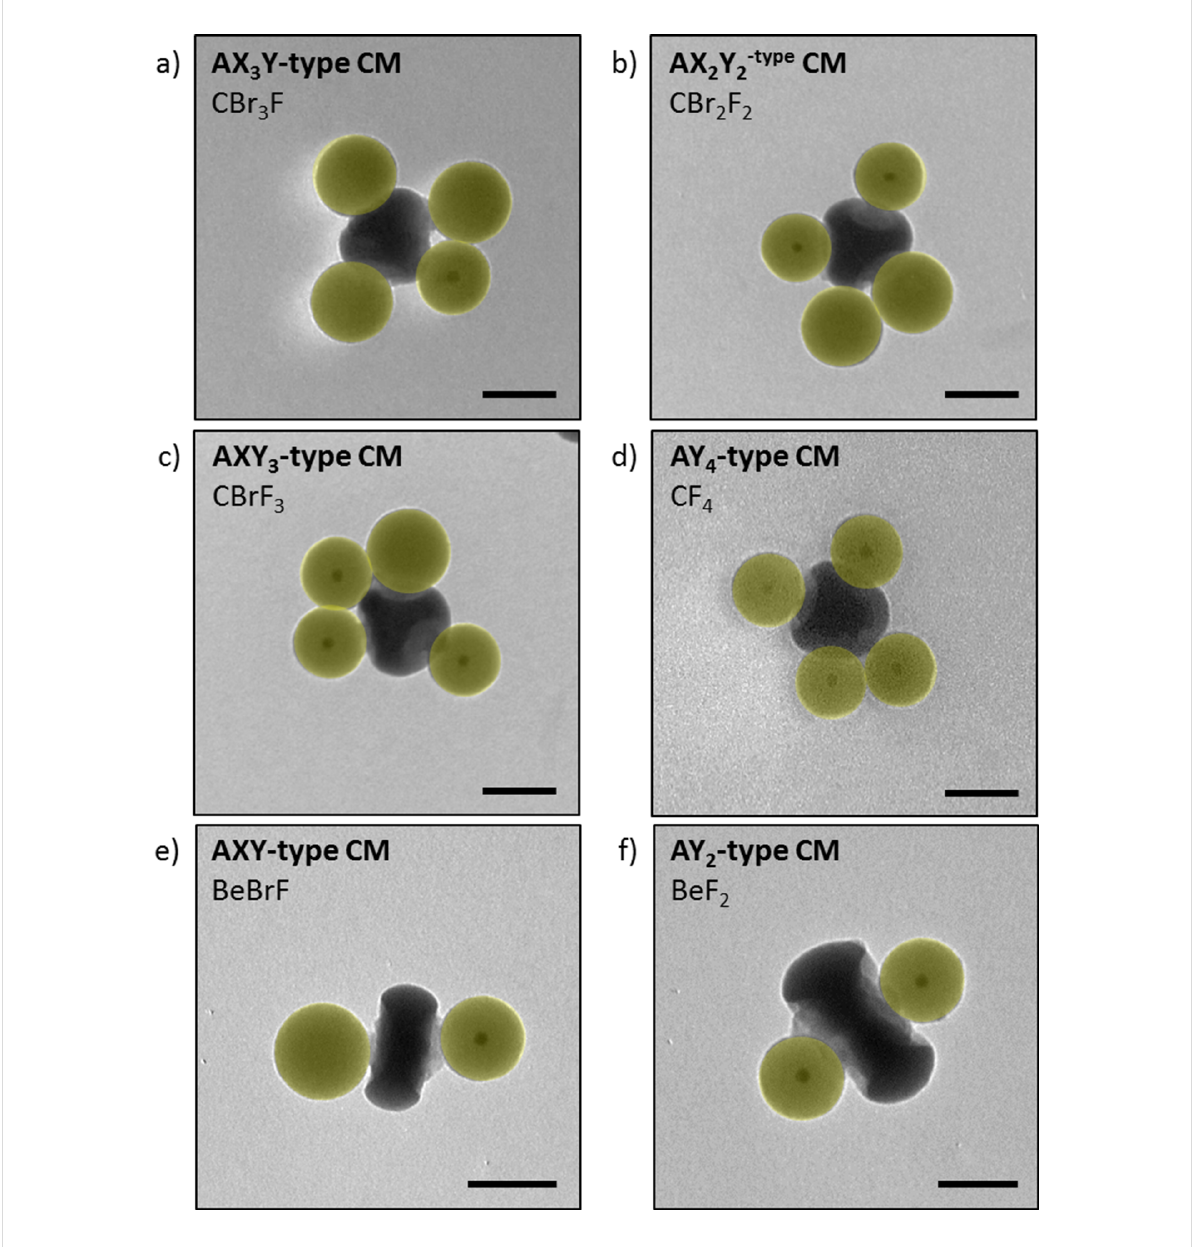
Figure 4: TEM images of the CMs obtained from mixing particles with four aminated dimples with 100 nm silica nanospheres and 90 nm core–shell nanoparticles in ratios of (a) 4 /3/1, (b) 4 /2/2, (c) 4 /1/3 and (d) 4 /0/4. TEM images of the CMs obtained from mixing particles with two aminated dimples with 100 nm silica nanospheres and 90 nm core–shell nanoparticles in ratios of (e) 2 /1/1 and (f) 2 /0/2 ratio; scale bars: 100